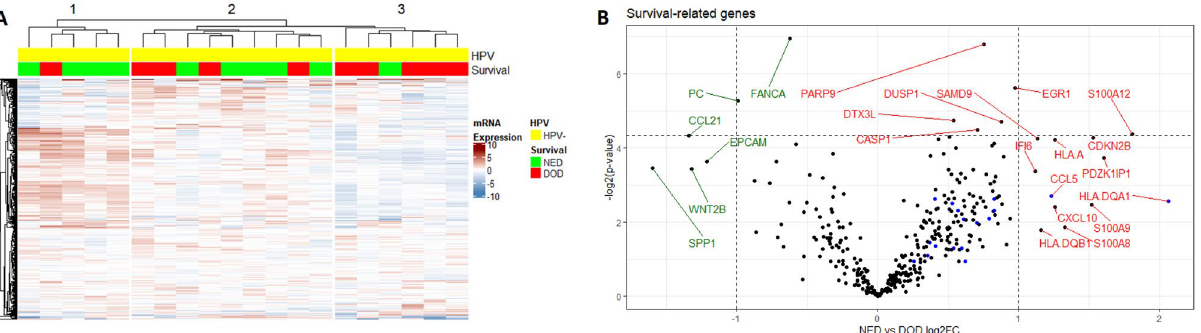
Figure 2. ( A ) Heatmap of all HPV-negative samples. Genes are rows and samples columns. ( B ) Volcano plot of transcripts differing between surviving and non-surviving patients with HPV-negative HPSCC. Transcripts higher in survivors are marked red. Unadjusted p values are presented and the horizontal line indicates an unadjusted p value of 0.05. Blue dots represent genes in the tumor inflammation signature. Analyses of mRNA expression were performed in R 3.6.2. Heatmaps were plotted with the R package ComplexHeatmap 40 . (https ://